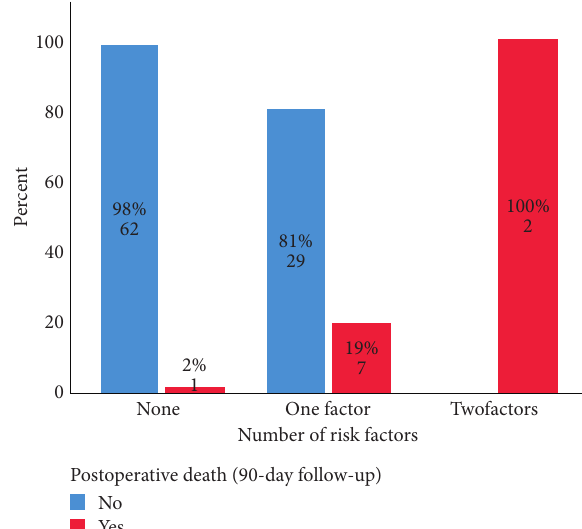
Figure 2: Postoperative death rate according to the number of risk factors.